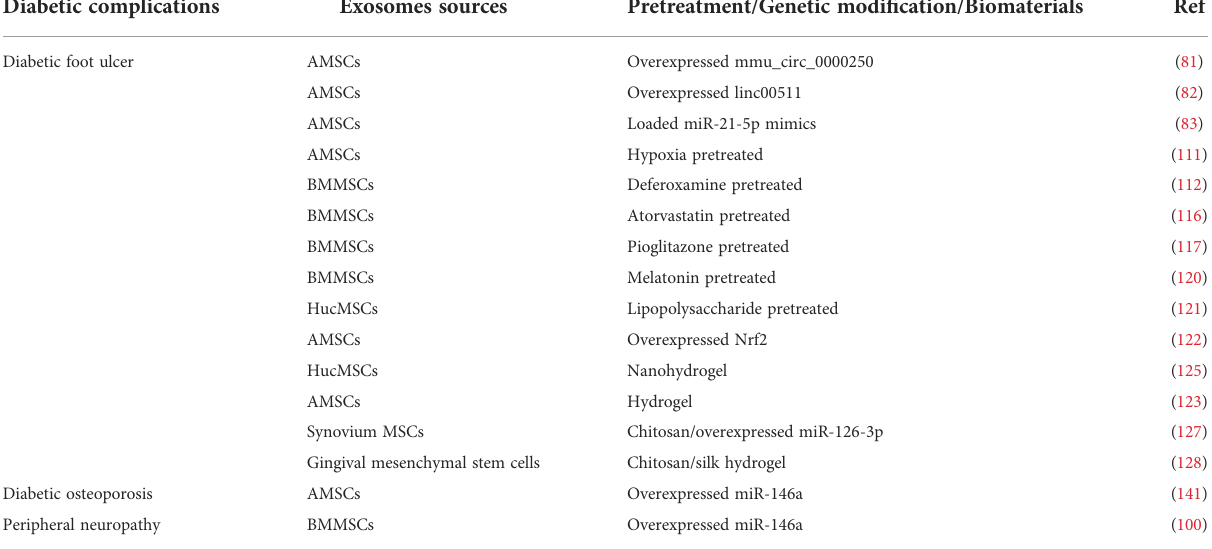
TABLE 2 The different exosome engineering strategies. Diabetic